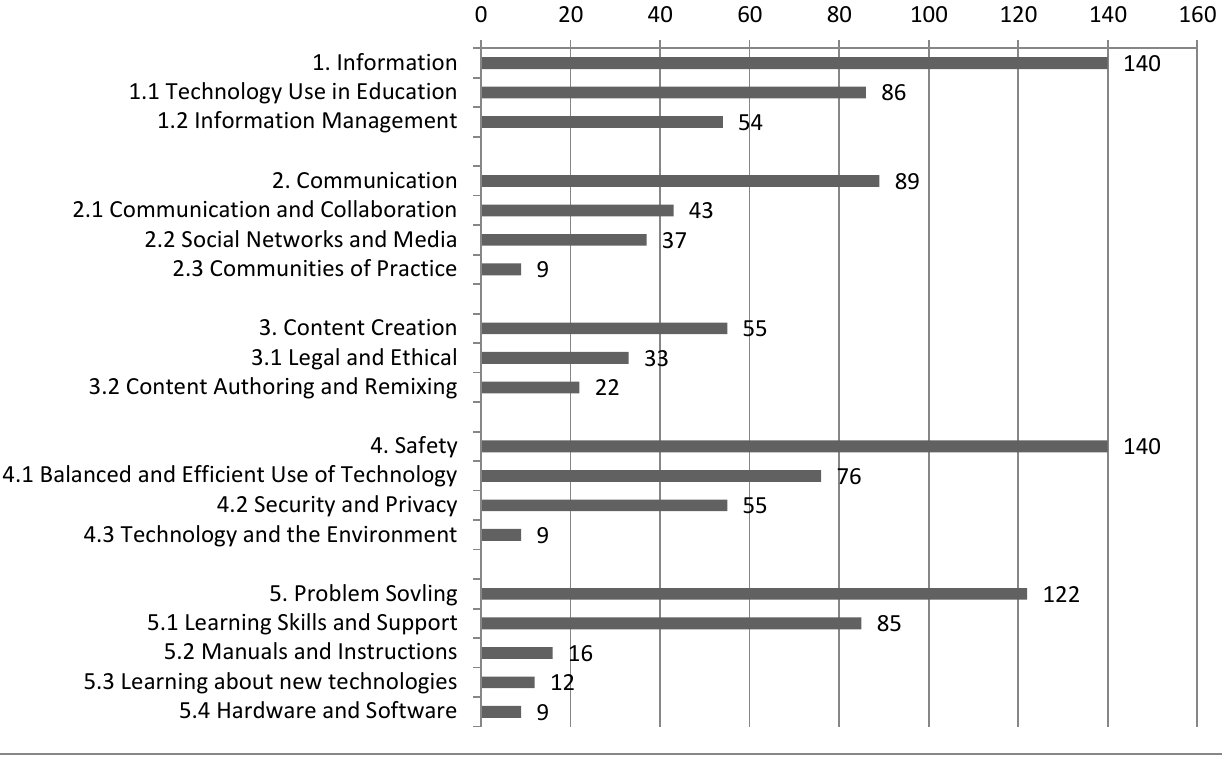
Figure 1 . Interview Themes Mapped onto the DIGCOMP Framework Areas (Final